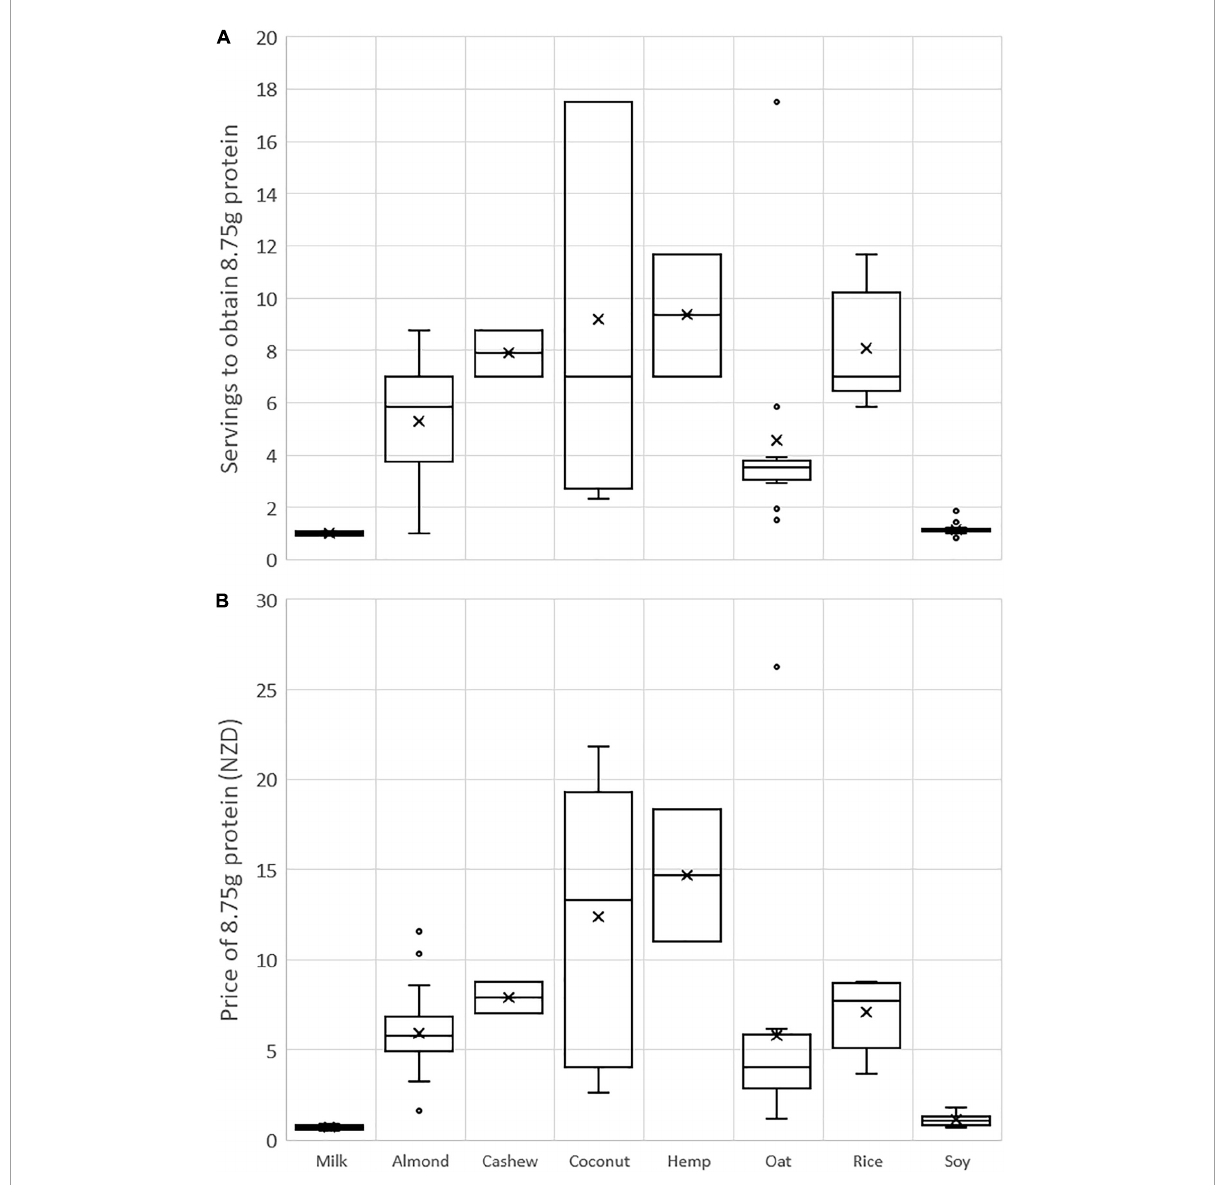
FIGURE1 Comparison of the number of servings (A) and the price (B) to obtain 8.75 g protein (equivalent to one serving of milk) from PBB. A serving size of 250 g was assumed for all products. Products with no protein content were omitted. The × symbol denotes the mean value; boxes show the median and interquartile range; range bars show the minimum and maximum values, excluding outliers (circles) that are more than 1.5 times the interquartile range below or above the first or third quartile,